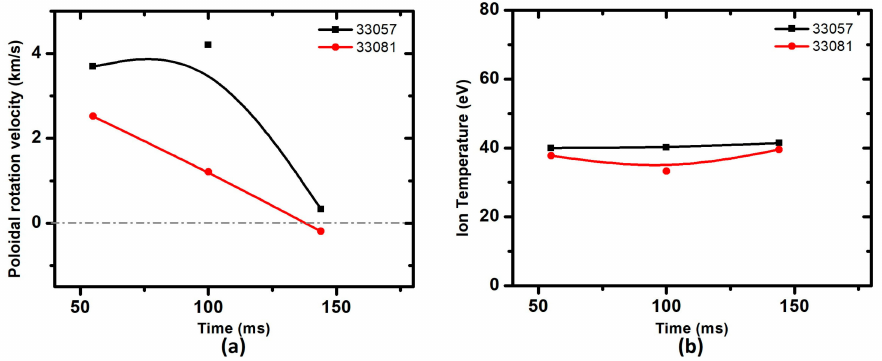
Figure 8. Temporal profile of ( a ) poloidal rotation velocity (km / s) and ( b ) edge ion temperature (eV) measured at 21.55 cm of plasma minor radius for discharges # 33057 and